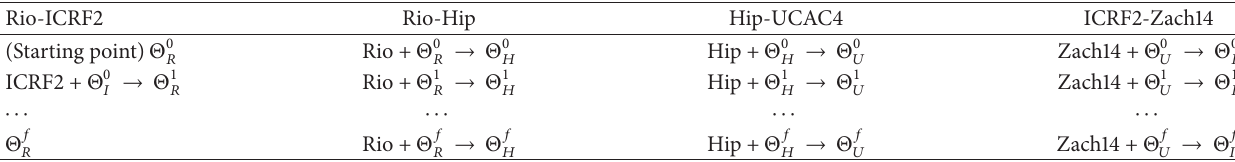
Table 1: Fixed point iterative process (see explanation in